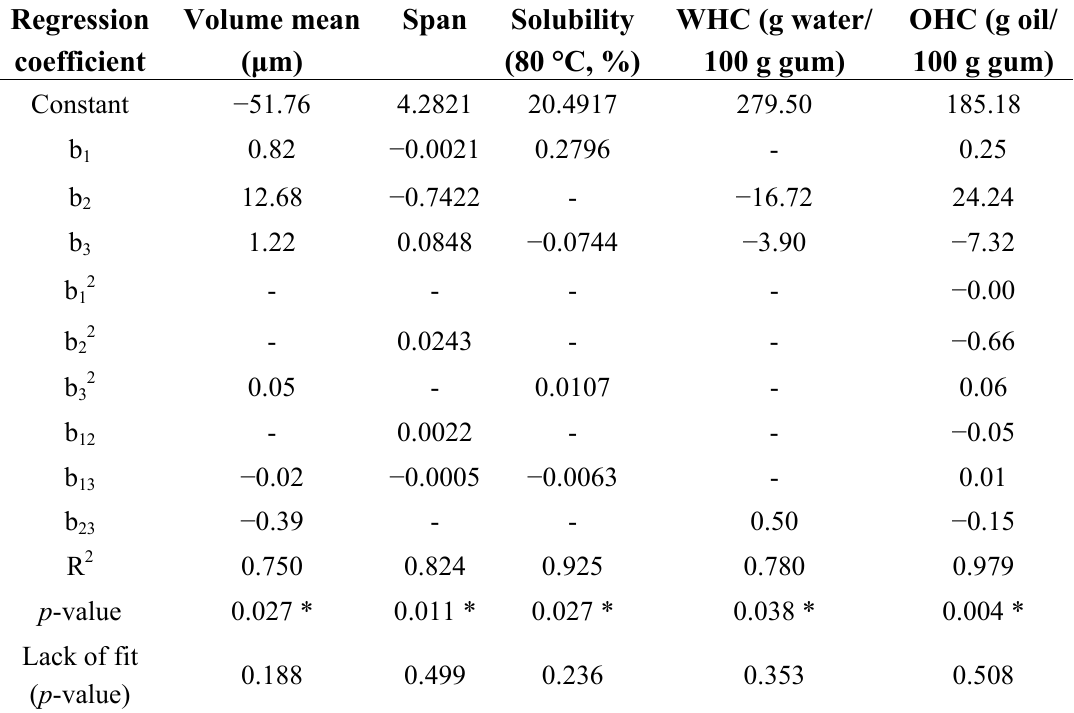
Table 1. Regression coefficients, R 2 and p-value of lack of fit for final reduced models. Regression